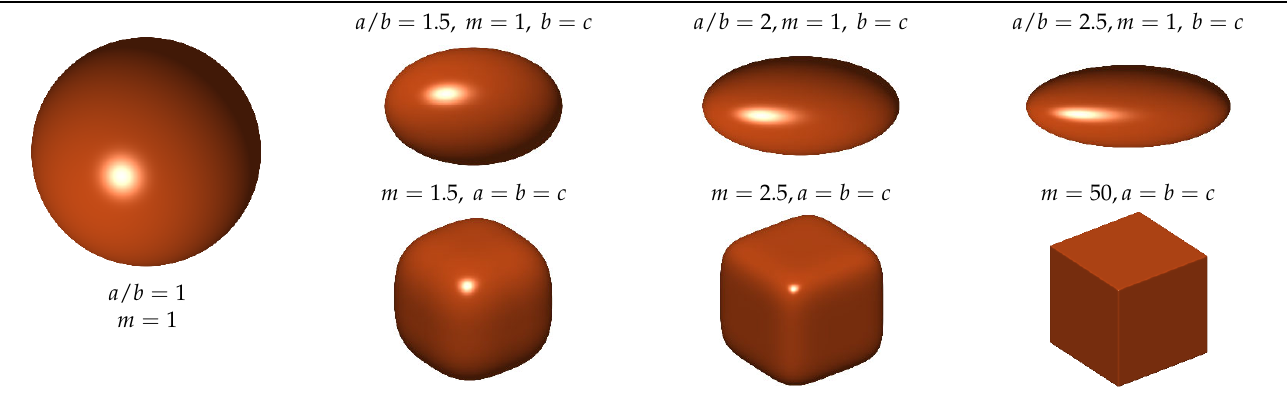
Table 2. A fraction of super ‐ ellipsoids with particular range.